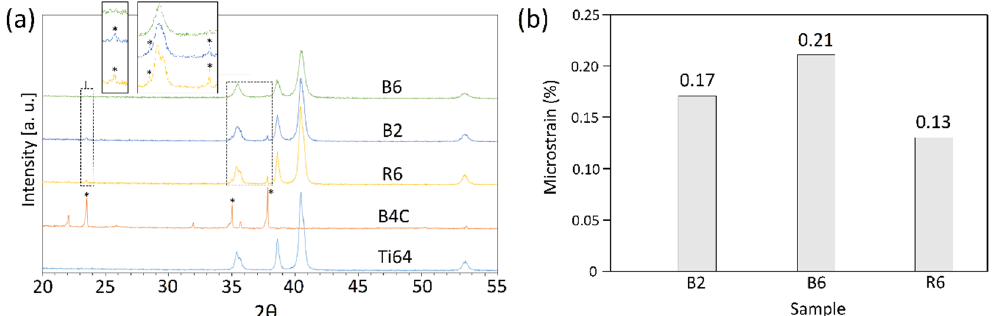
Figure 2. ( a ) XRD patterns of starting Ti ‐ 6Al ‐ 4V (Ti64) and B 4 C powders, as well as composite